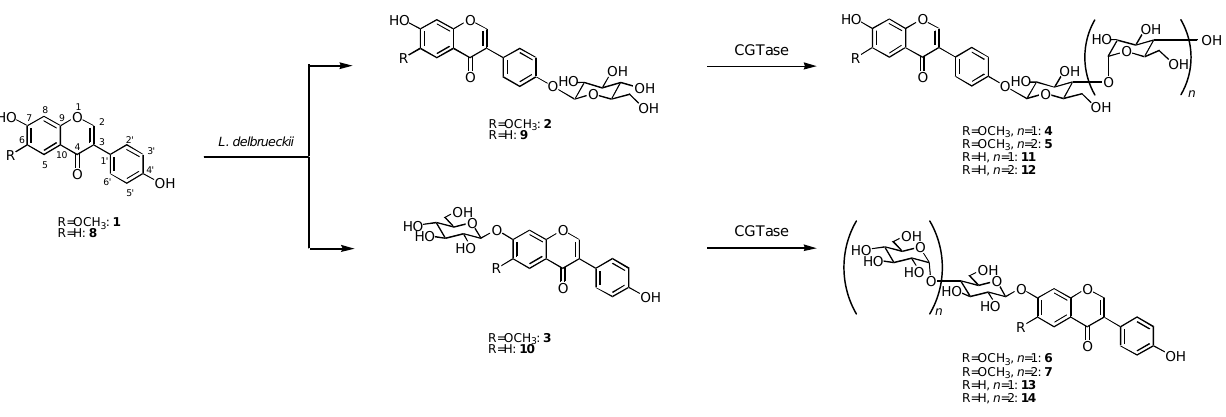
Figure 1. Synthesis of β -maltooligosaccharides of glycitein ( 1 ) and daidzein ( 8 ) by glycosylation with L. delbrueckii and